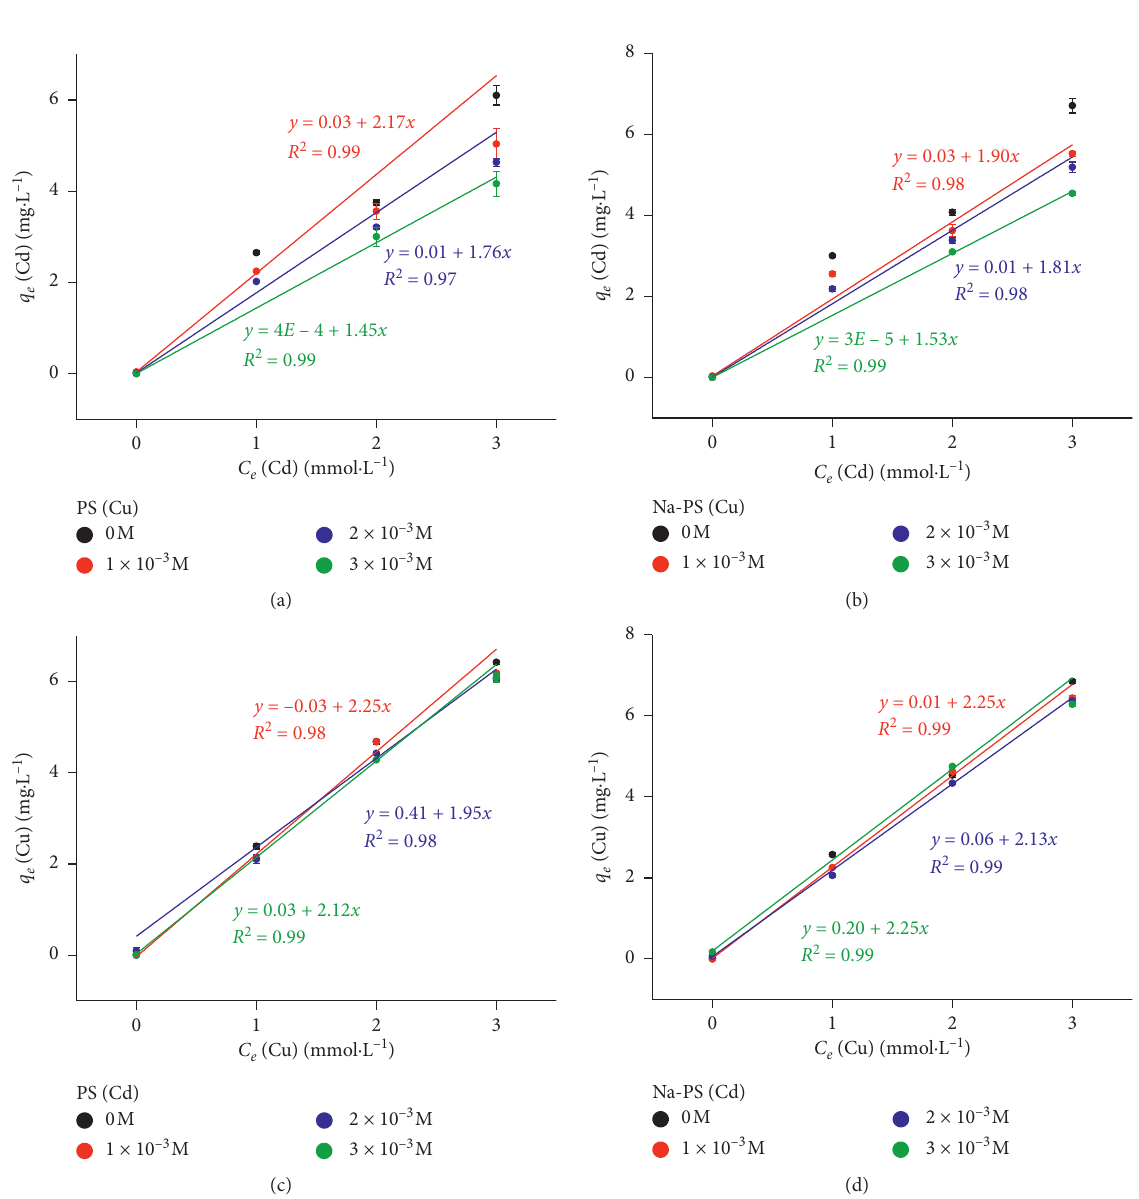
Figure 7: Influence of different concentrations of Cu(II) on the adsorption amount of Cd (II) on PS and Na-PS. Note: PS means Pisha sandstone; Na-PS means Pisha sandstone modified with Na + . Table 2: Parameters for the competitive solution of Cd(II) and Cu(II) on PS and Na-PS.